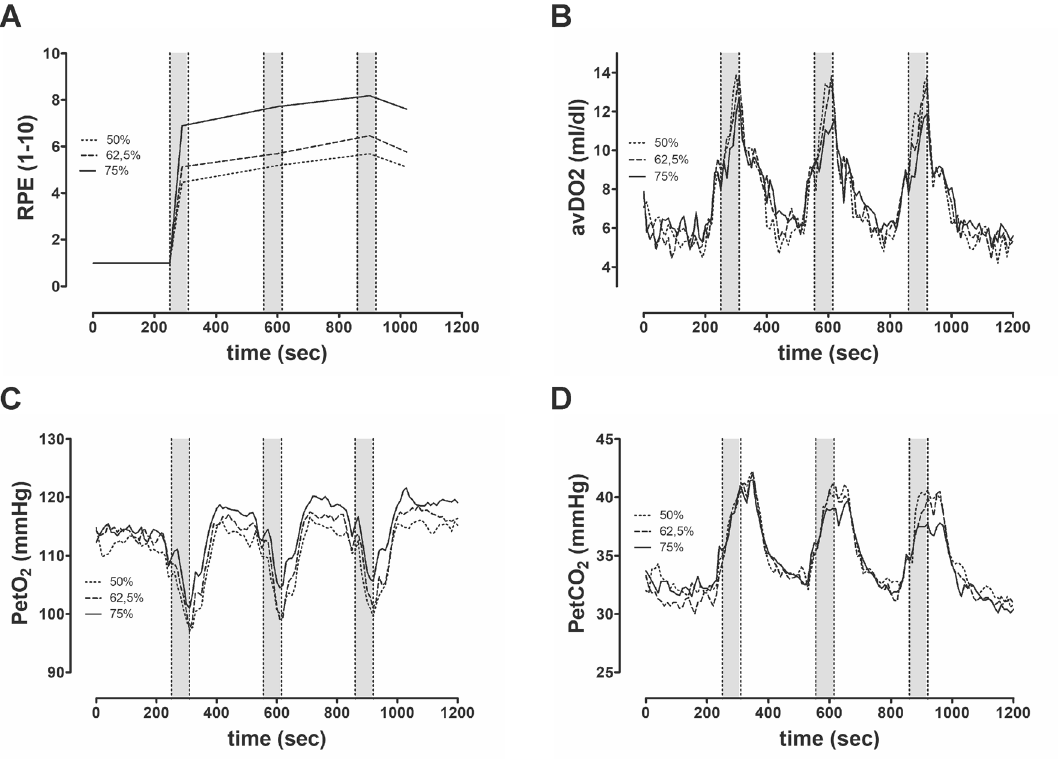
Figure 4. Graphs show the mean periphery and end-tidal course during strength training sessions with ( A ) Rating of perceived exertion; ( B ) Arteriovenous difference of oxygen ( C ) End-tidal oxygen-partial pressure, and ( D ) End-tidal carbon dioxide-partial pressure. 50% of